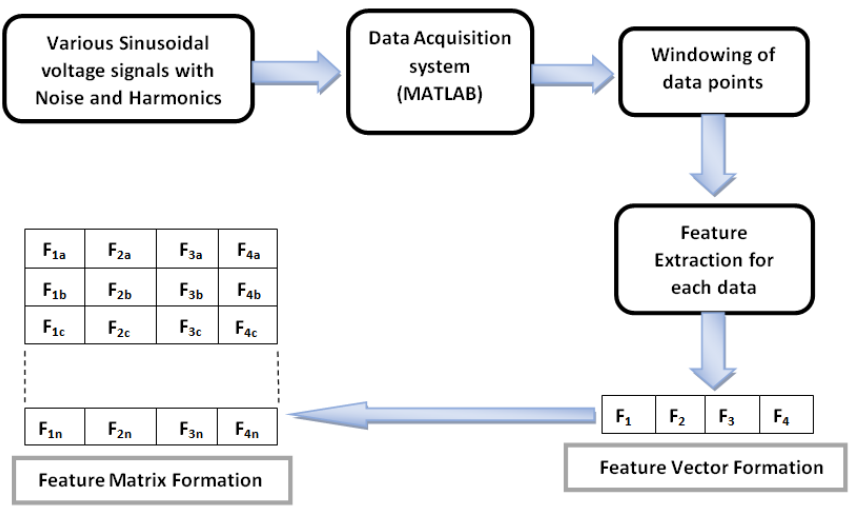
Figure 1. Mechanism of data